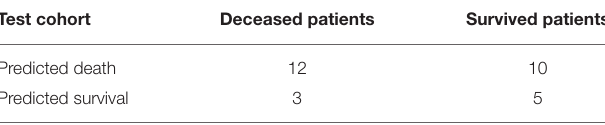
TABLE 2B | Confusion Matrix of PyRadiomics model in the test cohort. Test cohort